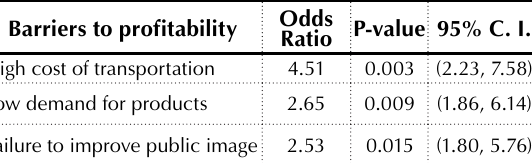
Table 6. Barriers to profitability of junior mines